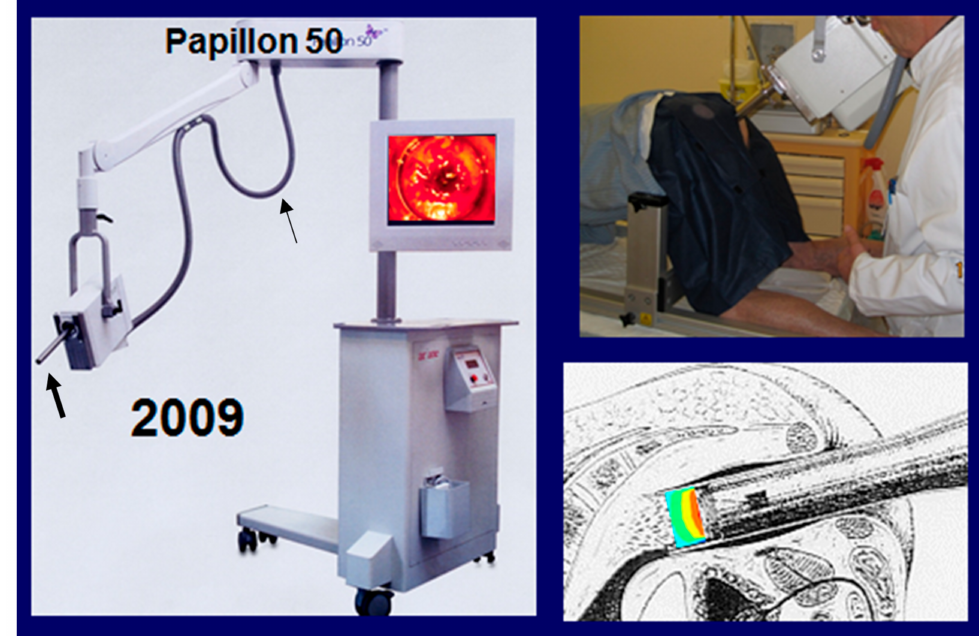
Figure 1. Illustration of CXB. ( Left ): The Papillon 50 TM system. Thick arrow: X-ray tube, also called a micronode. Plastic pipe (thin arrow) to circulate the mineral oil from the stand floor to the X-ray tube for anode cooling and allowing for a high dose rate (15 Gy/min). ( Upper right ): A treatment session. Patient in the knee–chest position. The rectal applicator is introduced in contact with the tumor under eye guidance and fixed (fisso arm). The X-ray tube is introduced into the rectal applicator to deliver the dose. ( Lower right ): Schematic drawing showing the X-ray tube introduced through the applicator in contact with the tumor. The FSD (focus surface distance is 4 cm). The focus is the anode (arrow) producing the 50 kV X-rays. Illustration of the dose distribution showing a sharp fall-off of the dose, which is 30 Gy at tumor surface (red) and 50% at 5 mm (green). There is nearly no dose to the rest of the rectal wall and surrounding tissues. It is a fully ambulatory treatment with good tolerance.